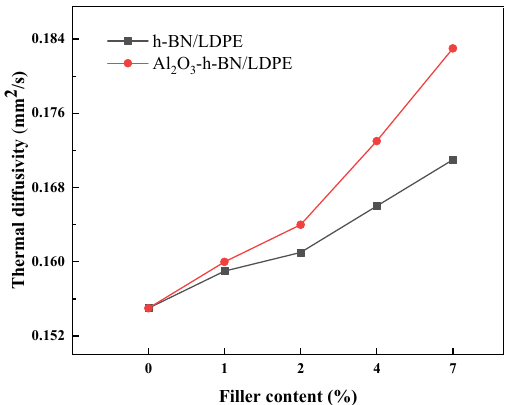
Figure 10. Thermal diffusion coefficients of h-BN/LDPE and Al 2 O 3 -h-BN/LDPE nanocomposite specimens with different doping contents.